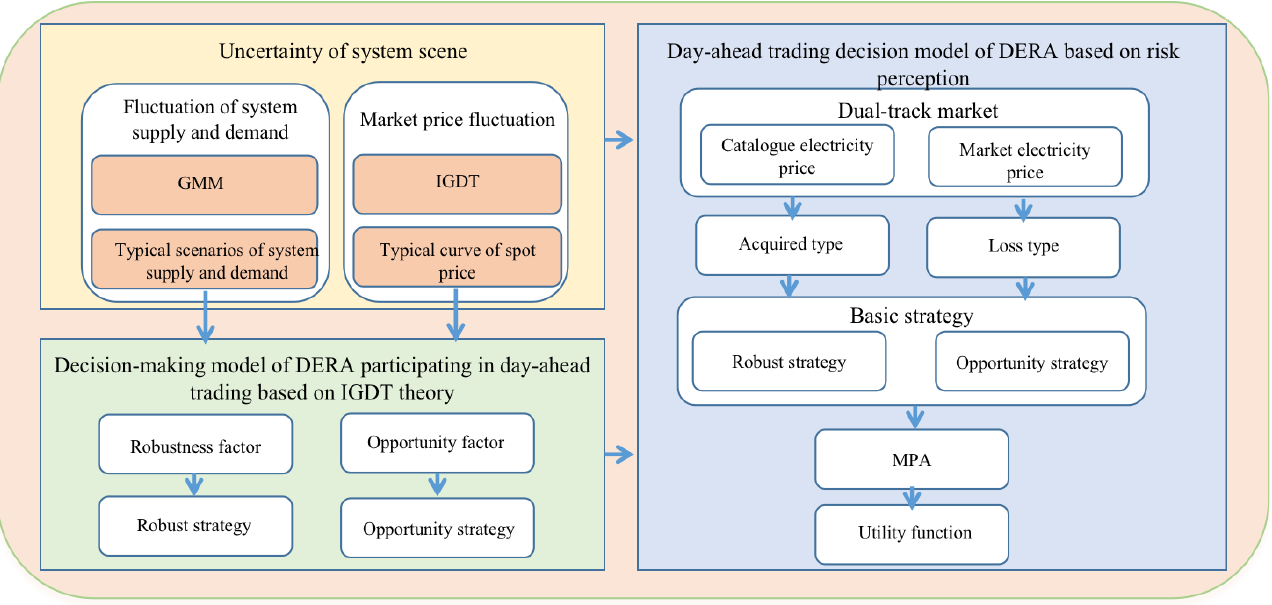
Figure 1. Research framework of single-stakeholder DERA transaction decision-making model in day-ahead market considering risk preference behaviors. day-ahead market considering risk preference